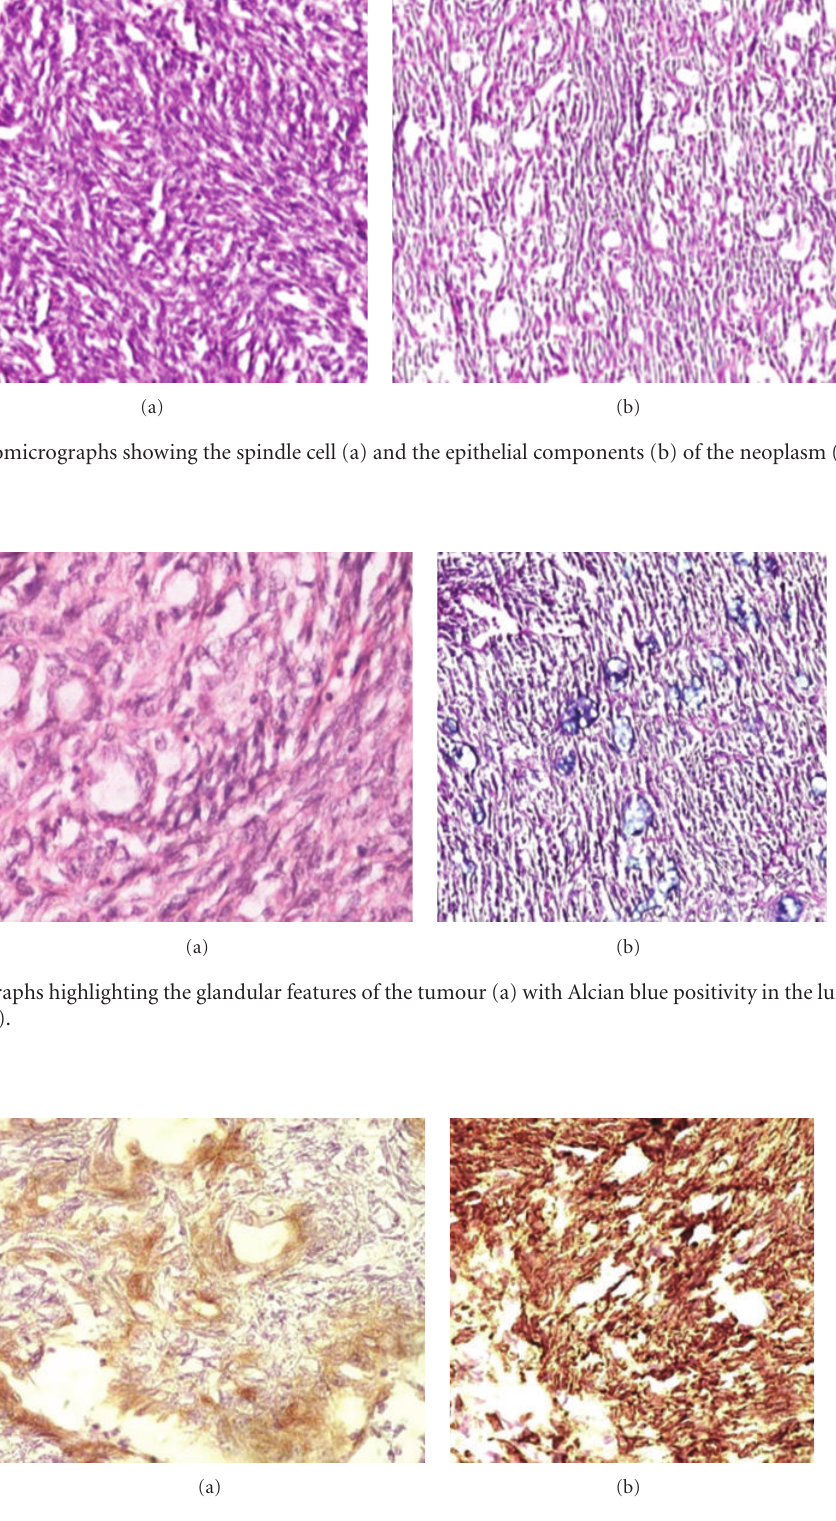
Figure 5: Immunohistochemistry showing positivity for EMA (a) and Bcl-2 (b) ( × 400 and × 200,